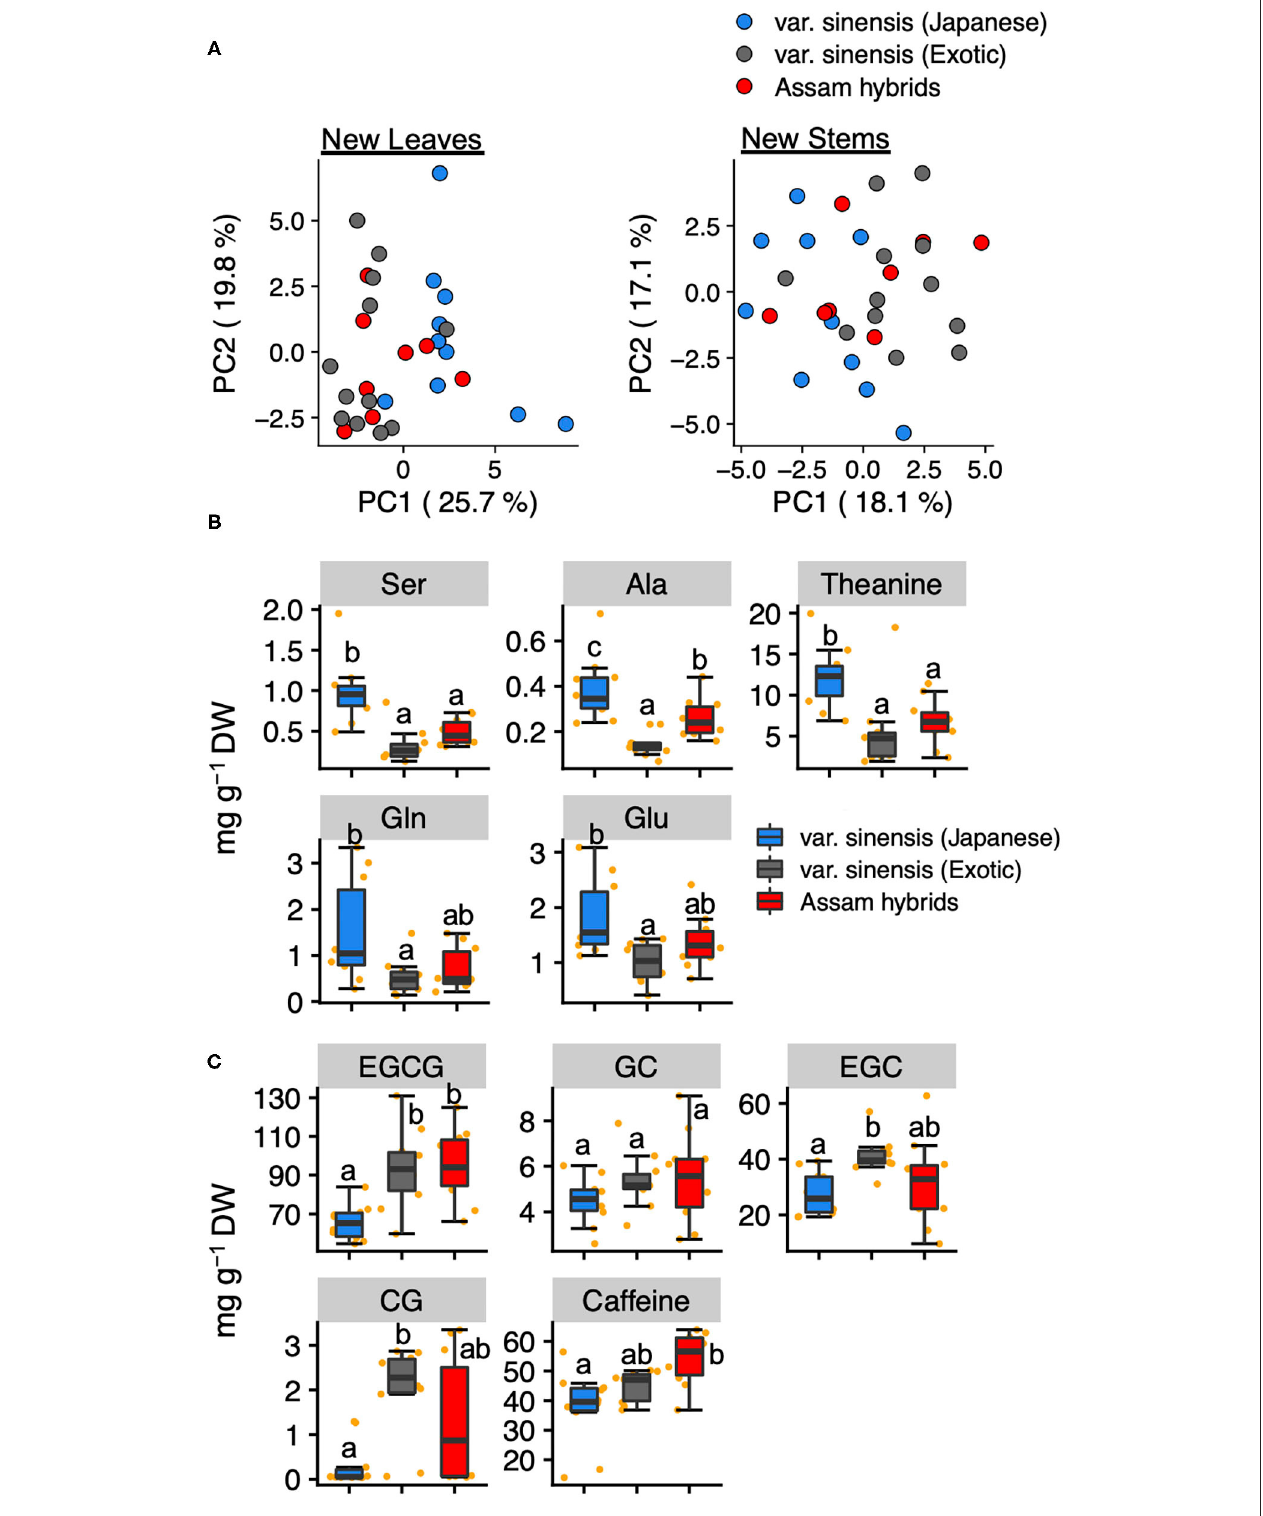
FIGURE 4 | Principal component analysis based on quantified tea quality-related metabolites in new leaves and stems. Plots of PC1 and PC2 in new leaves and stems (A) . Different plot colors represent tea genetic populations. Boxplots of the top five metabolites with positive (B) and negative (C) PC1 factor loading in the PCA of new leaves among genetic populations. Orange plots indicate the values of each accession. Different letters indicate significant differences (Tukey’s test, P < 0.05).